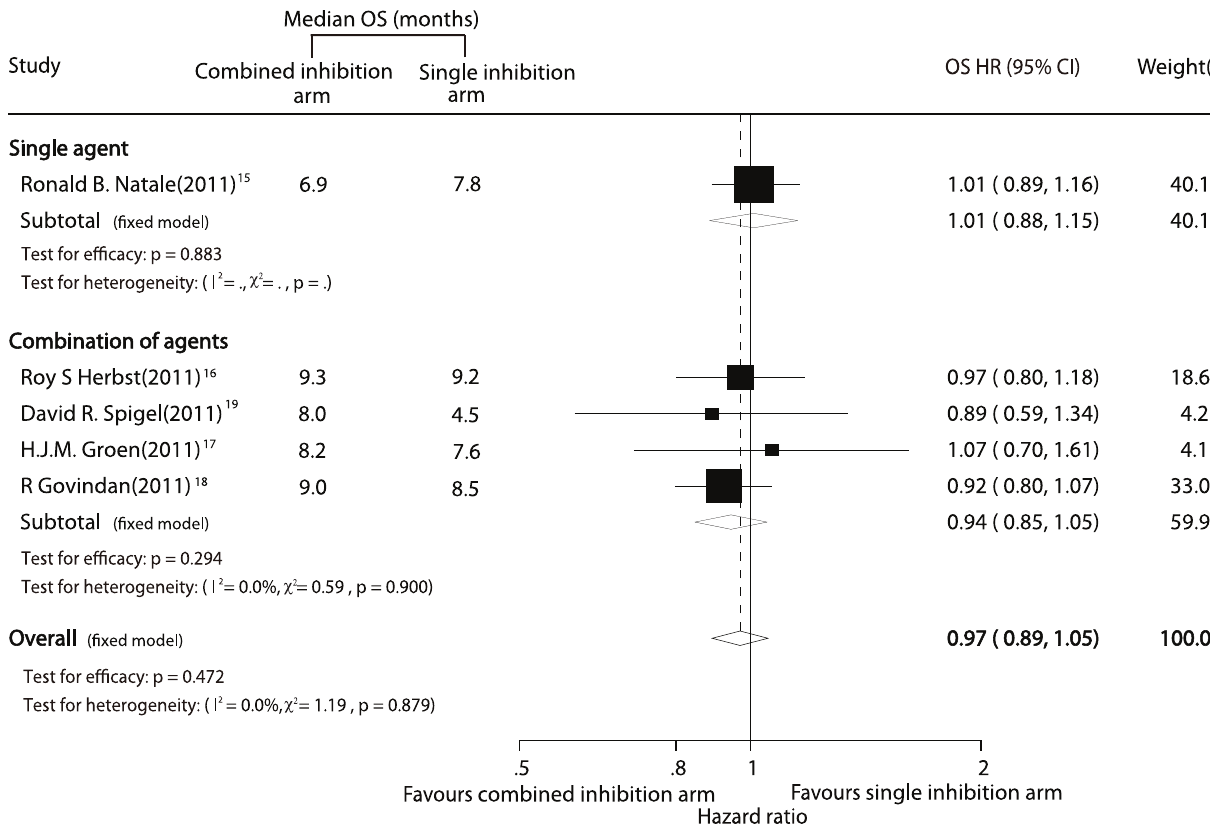
Figure 2. Comparison of overall survival between combined inhibition therapy and single inhibition therapy.